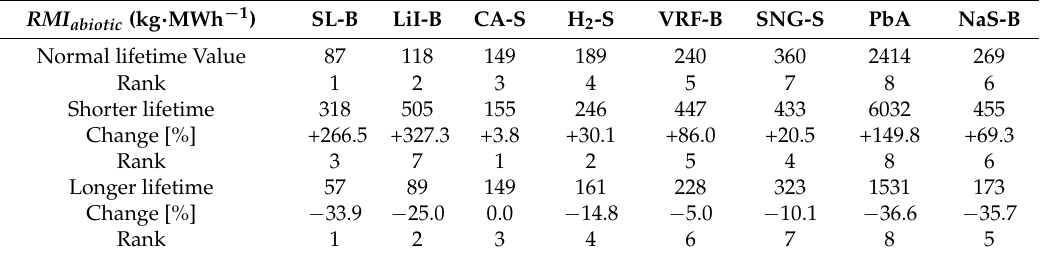
Table A2. Ranking of electrical energy storage technologies for RMI abiotic with normal, shorter and longer lifetime.